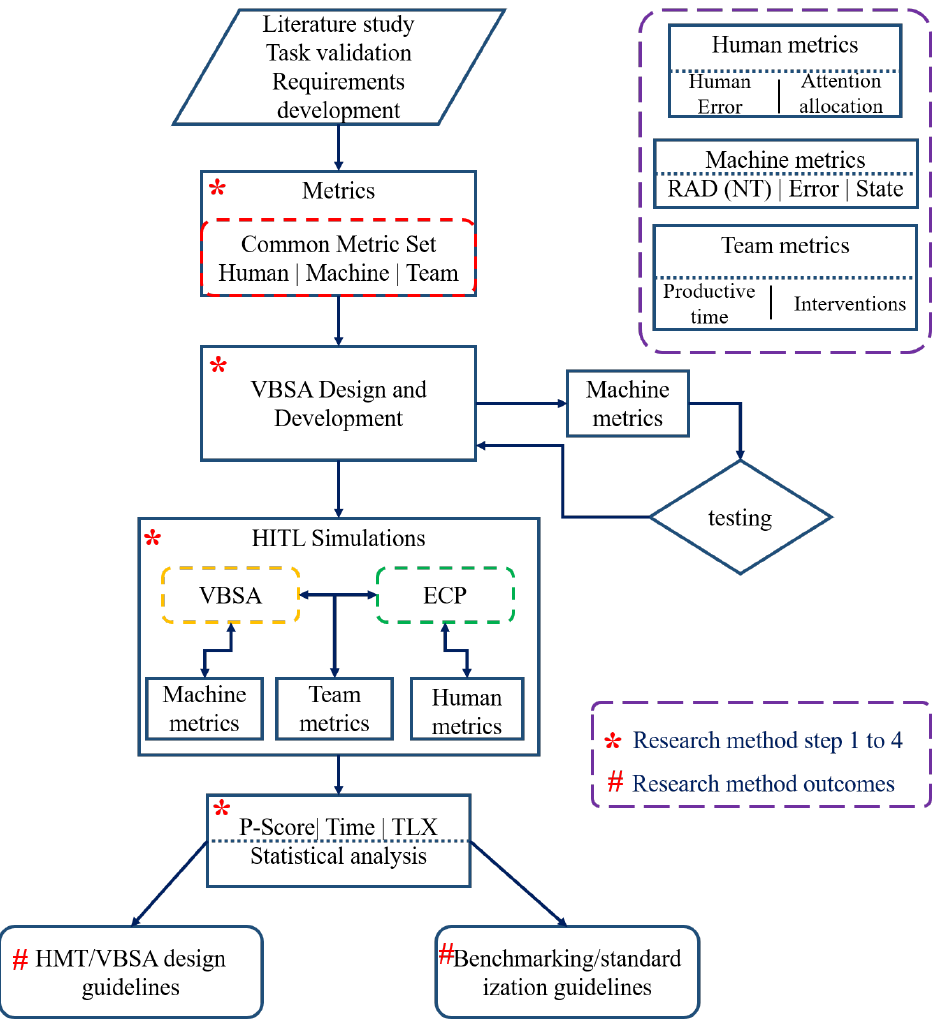
Figure 13. Hypothesized and validated HMT standardization method (reproduced from